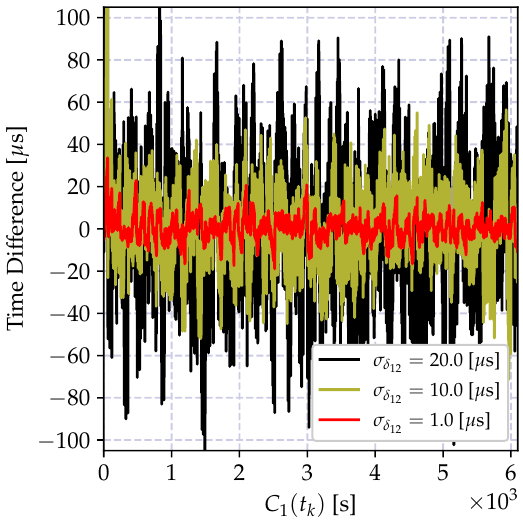
Figure 13. The variation of time difference in microseconds between the time reports of a local clock and a reference clock with standard deviation of zero-mean Gaussian stochastic messaging delay, denoted as σ δ . The time relation parameters of the incremental time model are estimated every 12 ∆ = 10 s using recursive weighted maximum likelihood estimator with weight λ =